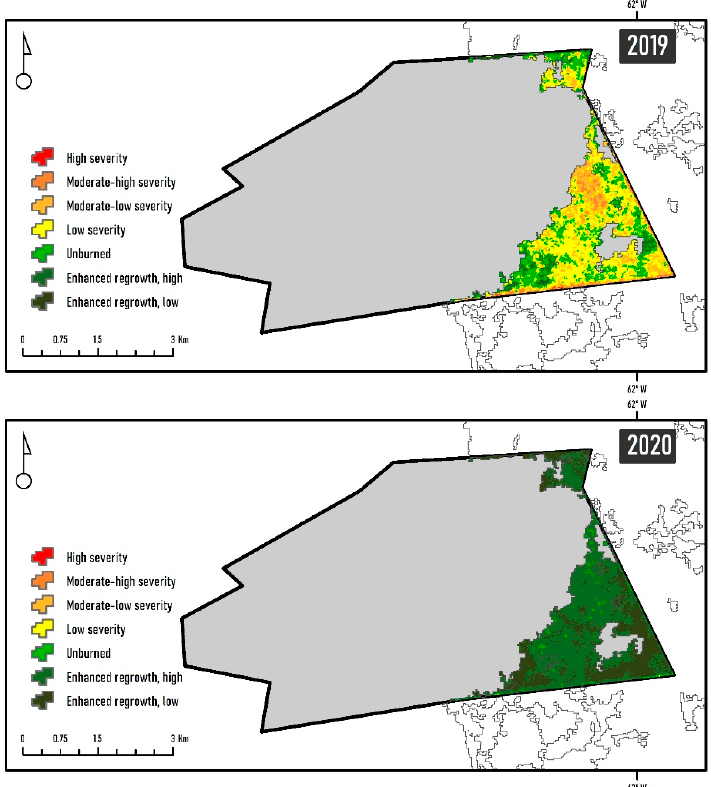
Figure 5. Fire severity levels based on dNBR at Alta Vista between 2019 and 2020.